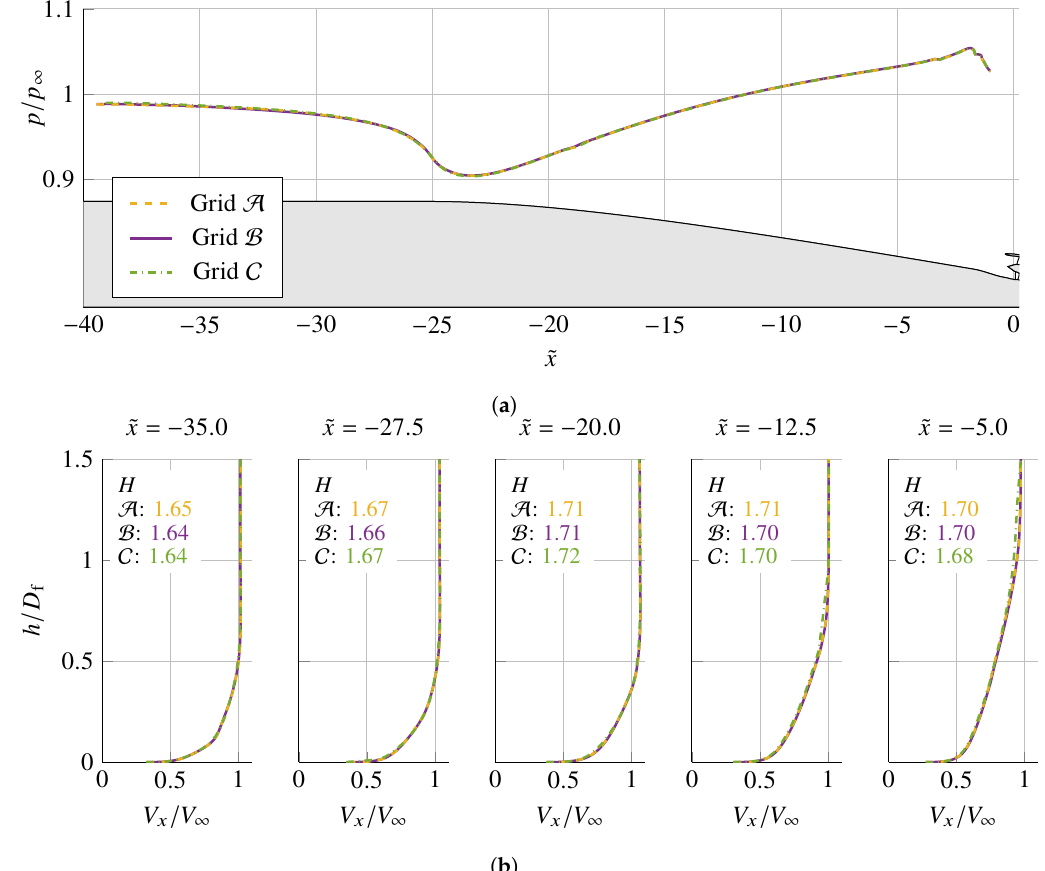
Figure A1. Flow field along the fuselage contraction at the centre plane for three different grids. ( a ) Surface static pressure distribution. ( b ) Boundary layer profiles and boundary layer shape factor H at various locations along the